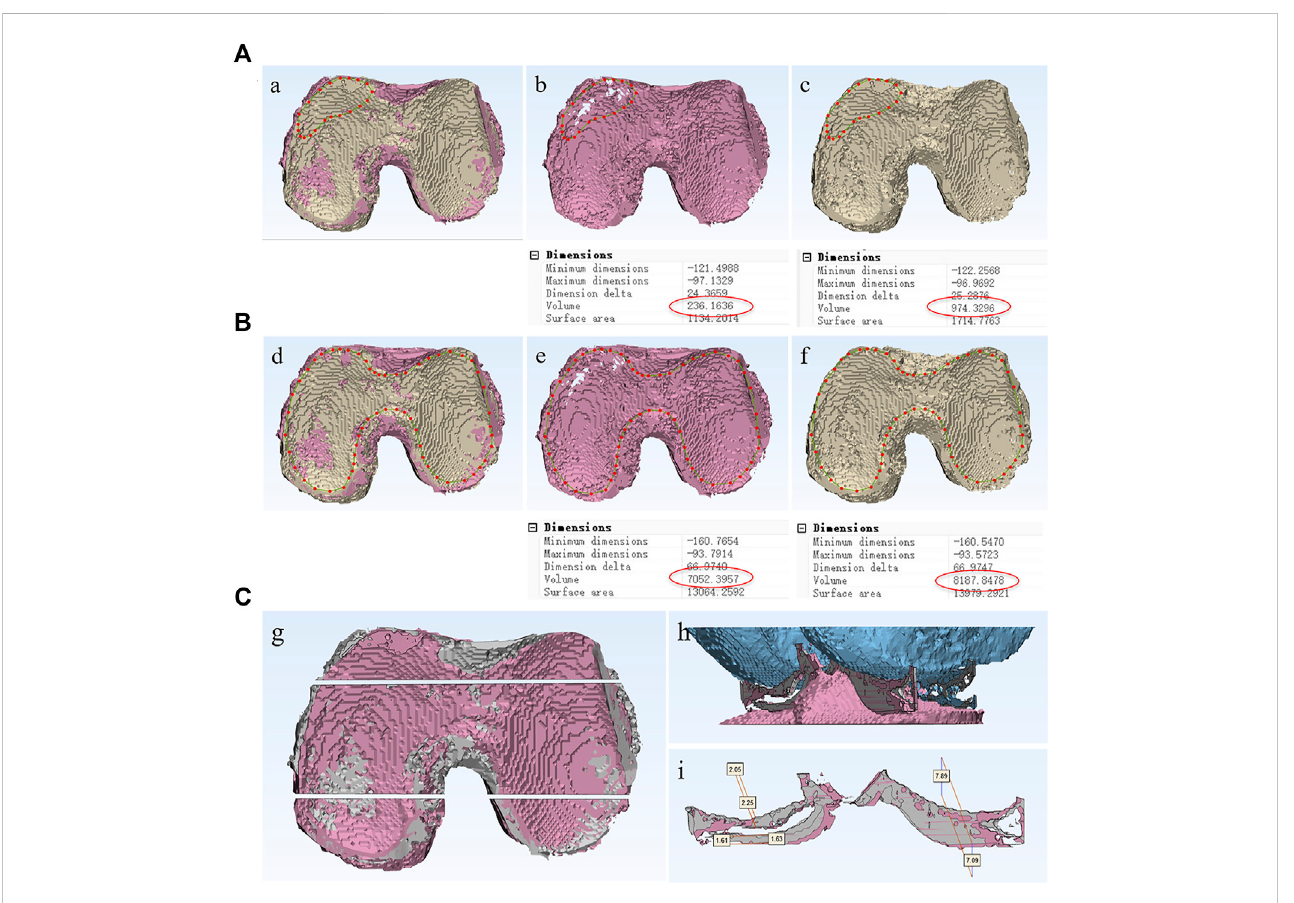
FIGURE 3 Quantitative analysis method of articular cartilage at different time periods. De fi ne the borderline of defect cartilage area (A) or entire articular cartilage area (B) ,and thevolumechanges between twodifferentperiods couldbemeasuredandcompared. (C) The kneejointwas coronalincisedattheanterior and posterior positions, the cross-sectional area of cartilage, as well as the thickness of femoral cartilage and tibial cartilage at each position could be measured respectively.